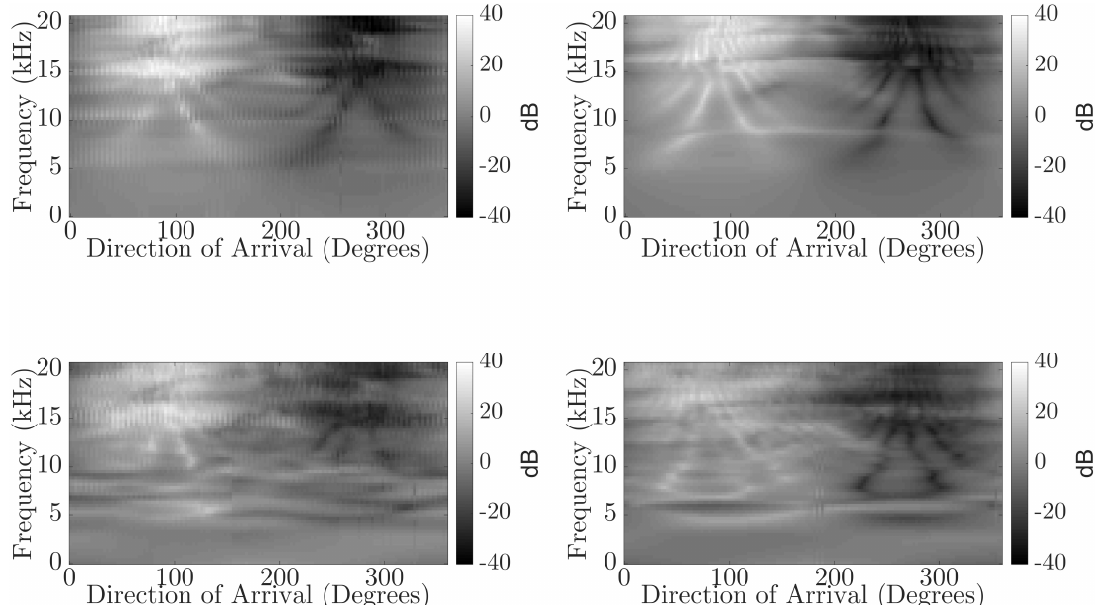
Figure 10. Comparison of interaural level difference across the direction of arrival for the KEMAR measured direct sound ( top left ), KEMAR measured reflection ( bottom left ), KU100 measured direct sound ( top right ) and KU100 measured reflection ( bottom right ).